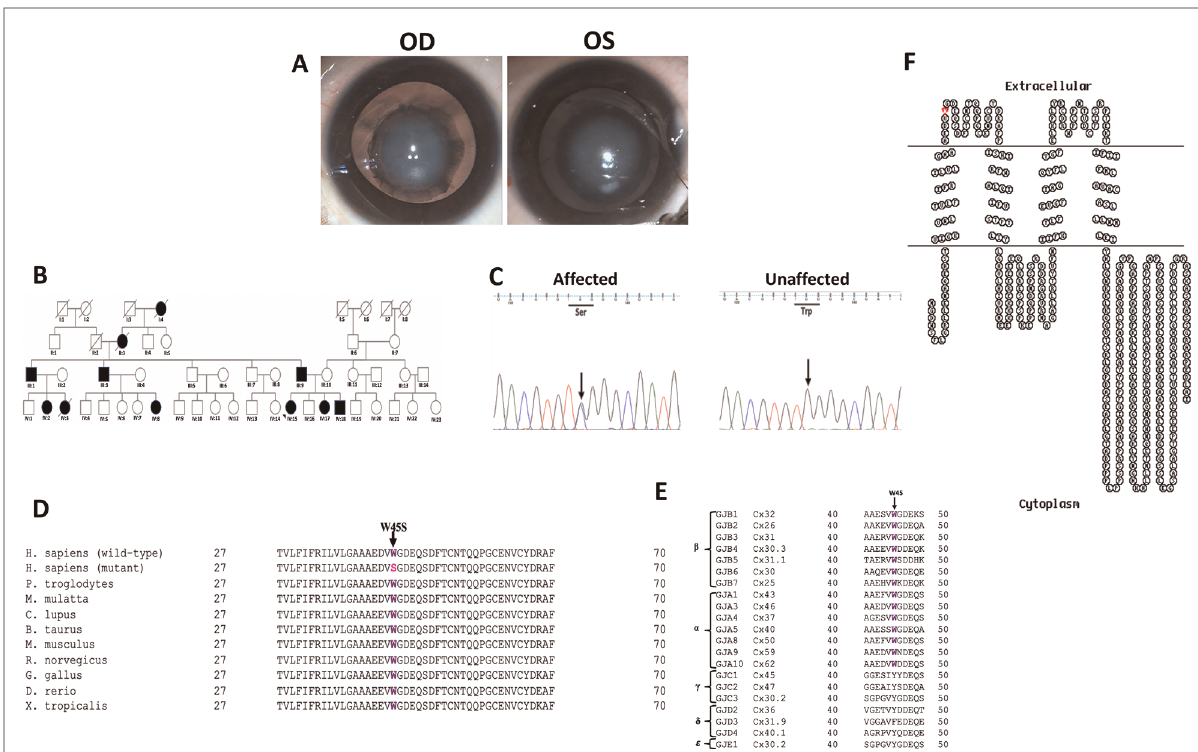
FIGURE 2 ( A ) Clinical photographs (OD and OS) of the proband (IV:15) of the PC-12 family indicating nuclear cataract. ( B ) Pedigree of an autosomal dominant congenital cataract family indicating 11 members in four generations affected with congenital cataract. The proband is indicated with an arrow. Squares and circles symbolize male and female individuals, respectively. Squares/circles with diagonal lines represent deceased persons. ( C ) Electropherograms of a part of the reverse strand sequence of exon 2 of GJA3 in the affected individual (IV:15). Arrow indicates the nucleotide at which heterozygous change (GC) occurred that resulted in c.134G>C (p.W45S) in the affected individuals. Also shown is a part of reverse strand sequence of exon 2 of GJA3 in an unaffected individual (III:10) indicating wild-type (GG) genotype. ( D ) Multiple amino acid sequence alignment (NCBI HomoloGene) of GJA3 indicating conservation of tryptophan [W] (shown in purple) at position 45 as indicated by an arrow in different species. Mutant sequence [ Homo sapiens (mutant)] (replacement of tryptophan [W] by serine [S] at 45 position) in the affected members of the present analyzed PC-12 family is highlighted in pink. ( E ) Tryptophan at position 45 (indicated by an arrow) is highly conserved in different members of β and α human gap junction proteins (connexins). However, it is not conserved in the members of γ , δ , and ε connexins, as only subfamily α and β are sister groups with maximum likelihood of 95% and Bayesian posterior probability of 1 (38). ( F ) The membrane topological structure of GJA3 was generated by TOPO2 software (http://www.sacs.ucsf.edu/TOPO2/). The mutation p.W45S (indicated by red dot) is in the fi rst extracellular